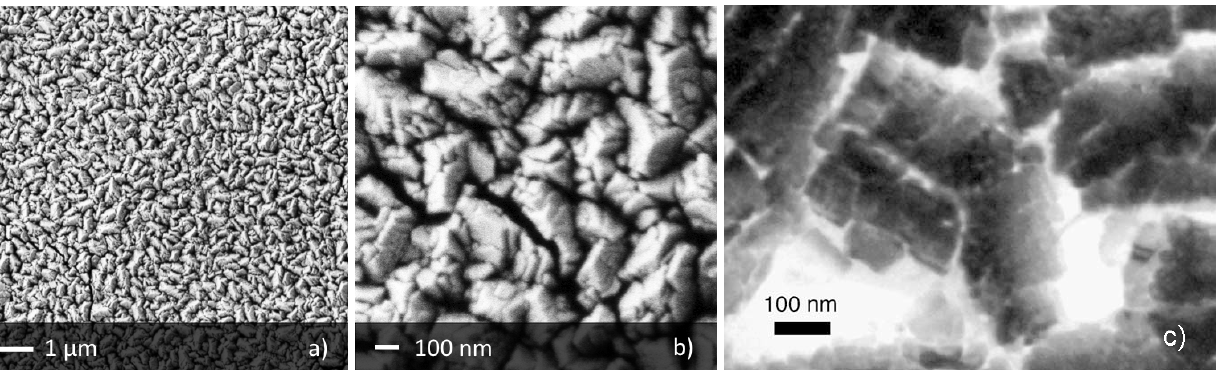
layer prepared by the thermal evaporation method Figure 4. SEM images of the WO 3 developed at sensor lab, ( a ) and ( b ). TEM bright field image of the structure of WO agglomerate ( c ) (reprinted from [18] with permission of Elsevier, copyright